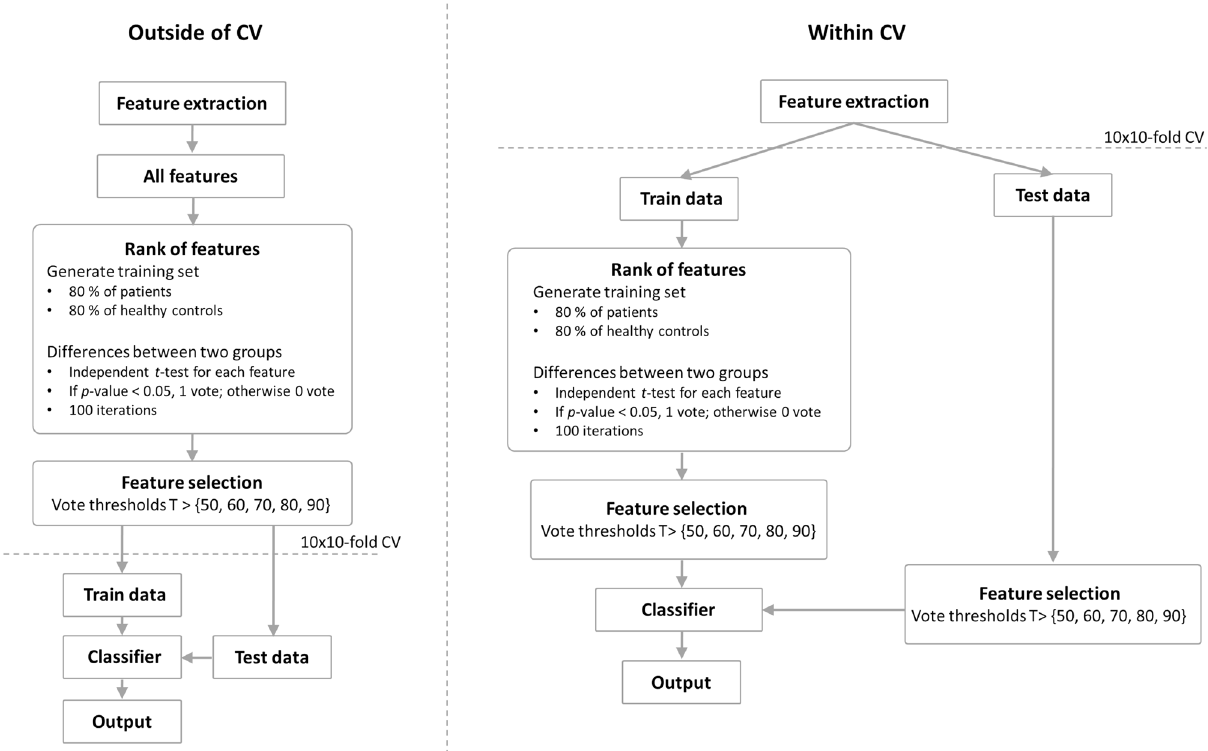
Figure 1. Flowchart of two different feature selection strategies. Left panel: all features were used for the feature selection method performed outside of CV, and then selected fixed features were used to evaluate the prediction performance, at which time CV was applied. Right panel: contrary to the feature selection method performed outside of CV, CV was applied in the stage of feature selection for the feature selection method performed within CV, where the features in the training set were only used for feature selection, and then the corresponding features in the test set were used to evaluate the prediction performance. Outside of CV Within CV Vote threshold n